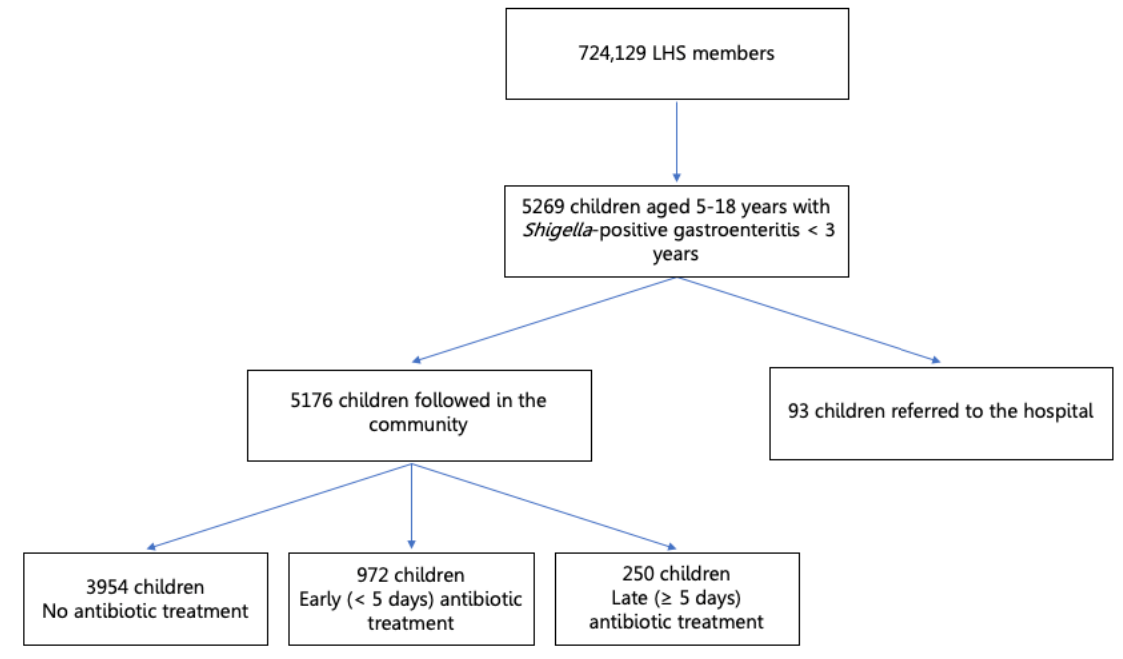
Figure 1. Study flowchart.